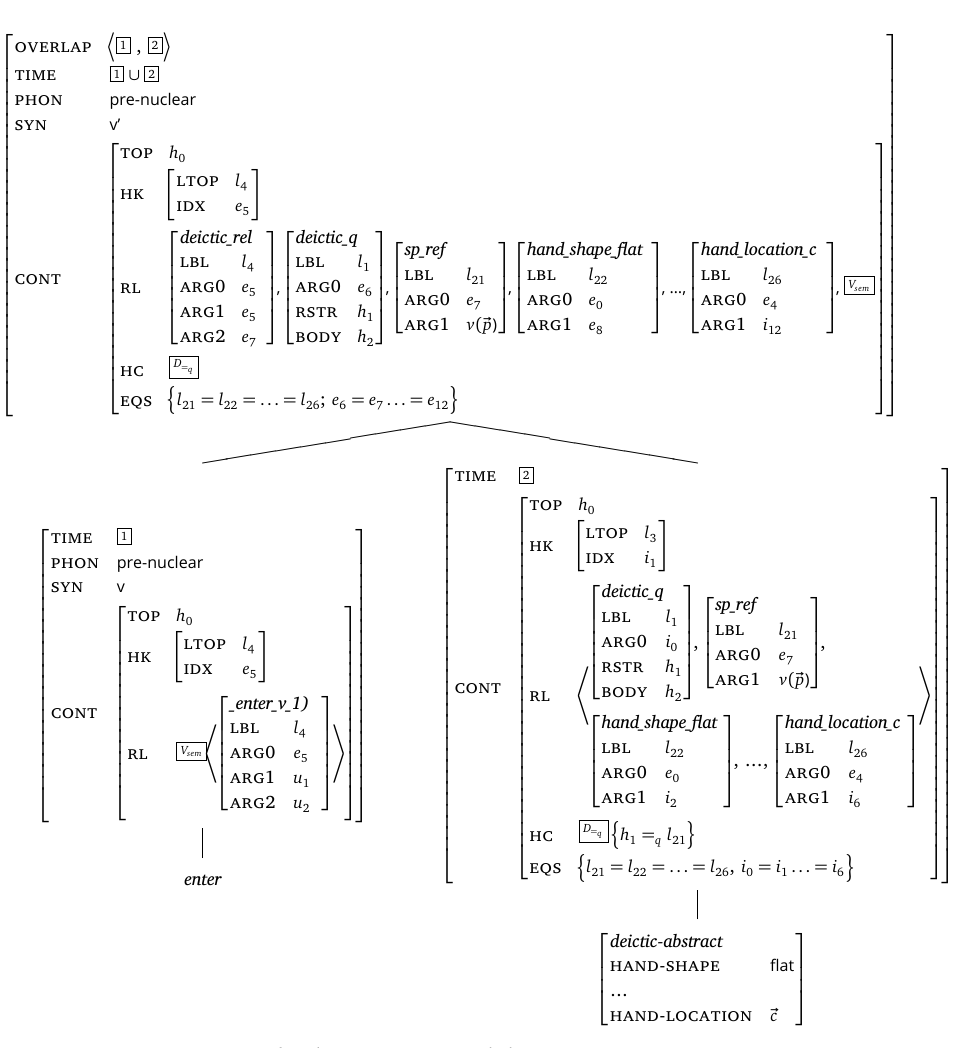
Figure 7: Derivation tree for deictic gesture and the V “enter”